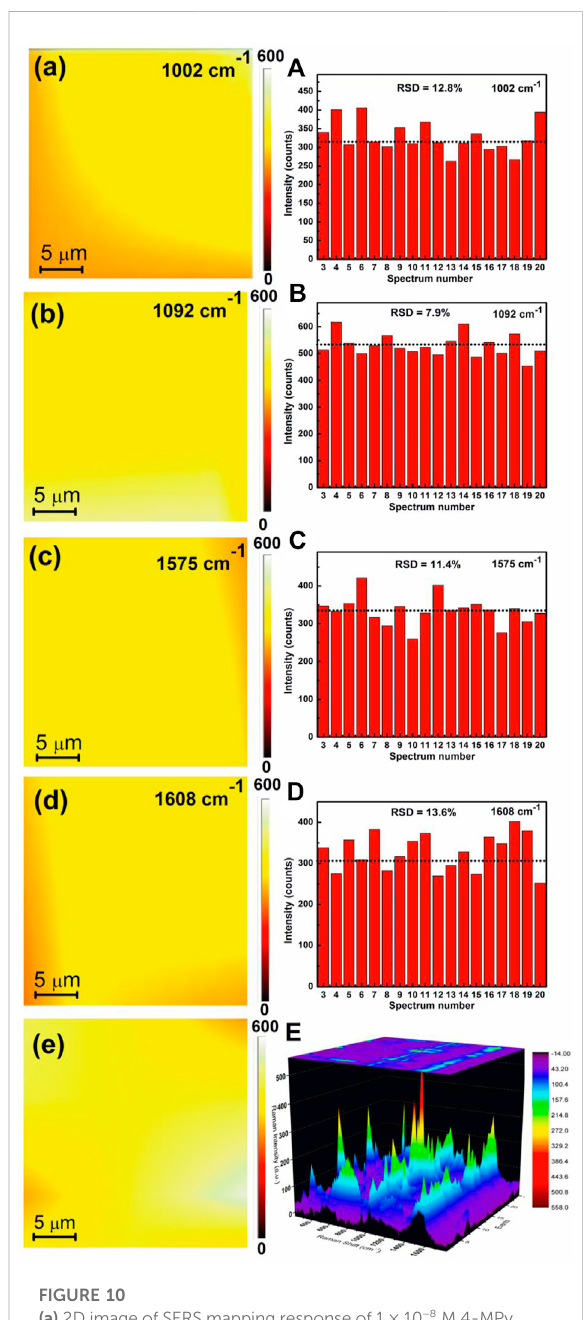
FIGURE 10 (a) 2D image of SERS mapping response of 1 × 10 − 8 M 4-MPy molecule adsorbed on the APS over the area of 25 × 25 µm for (a) 1002 (b) 1092 (c) 1575 (d) 1608 cm − 1 band. The relative standard deviation (RSD) of SERS signals intensity for the corresponding bands (A – D) . (e) Average SERS mapping and